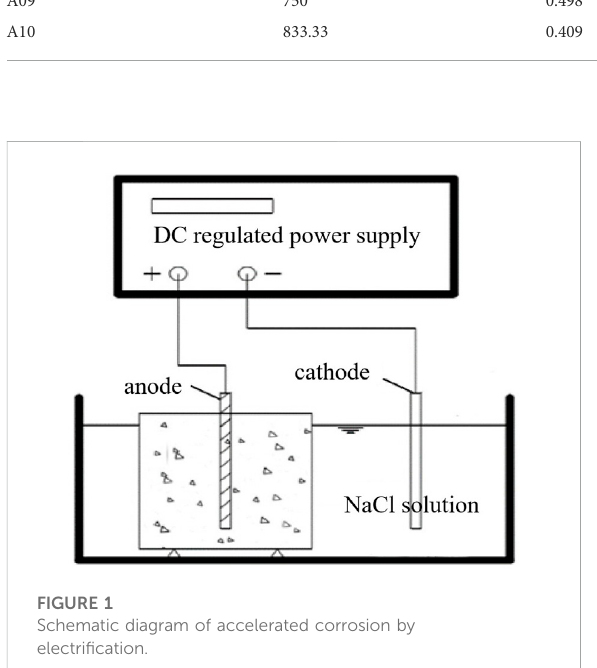
FIGURE 1 Schematic diagram of accelerated corrosion by electri fi